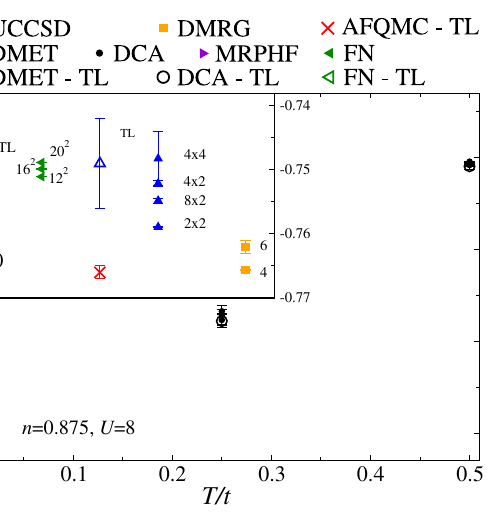
FIG. 7. Data for n ¼ 0 . 875 for U=t ¼ 8 . Main panel: Temper- ature dependence of double occupancy D , compiled from various techniques. Solid symbols represent finite systems; open symbols represent extrapolations to the thermodynamic limit. Finite- T results are shown for DCA (black circles), and zero- T data from DMET (blue triangles), MRPHF (purple triangles), UCCSD (maroon diamonds), DMRG (orange squares), and FN (green triangles). Inset: Zoom-in of the zero- T data from FN, AFQMC, DMET, and